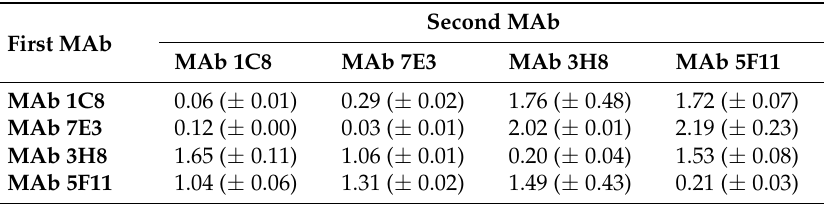
Table 2. Summary of the binding ratios of paired monoclonal antibodies on the immobilized flagellin. First